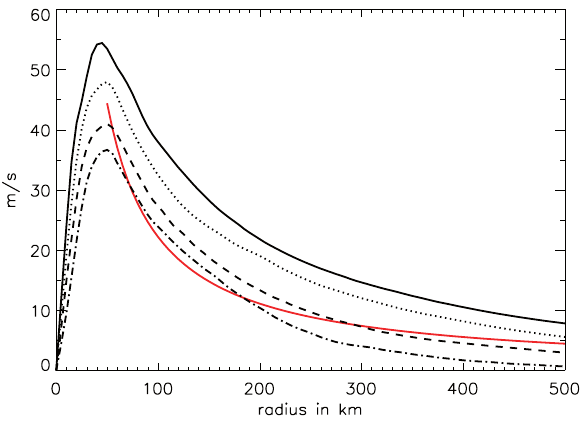
Figure 2. Azimuthally averaged radial profiles of tangential winds for the no shear case of RMN at 2 km (solid), 5 km (dotted), 8 km (dashed), and 10 km (dash-dotted), averaged over a 6 h period after 48 h of spin up. These profiles represent the TC wind structure at the time at which shear is imposed. For comparison, the profile for the Cat1 point vortex (red) is shown outside of 50 km.